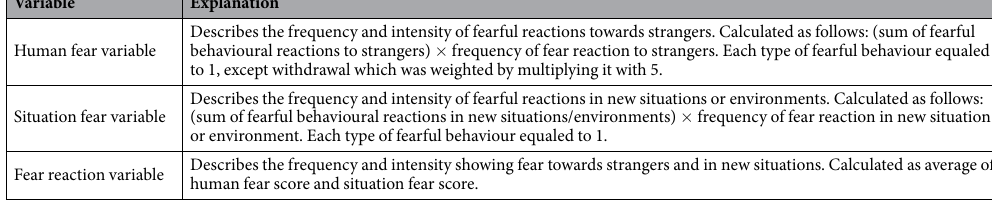
Table 5. The definitions of behavioural variables derived from the canine behavioural questionnaire data. Variables describe the dog’s fearful reaction either towards strangers (human fear variable) or in new situations (situation fear variable), and the combination of these reactions (fear reaction